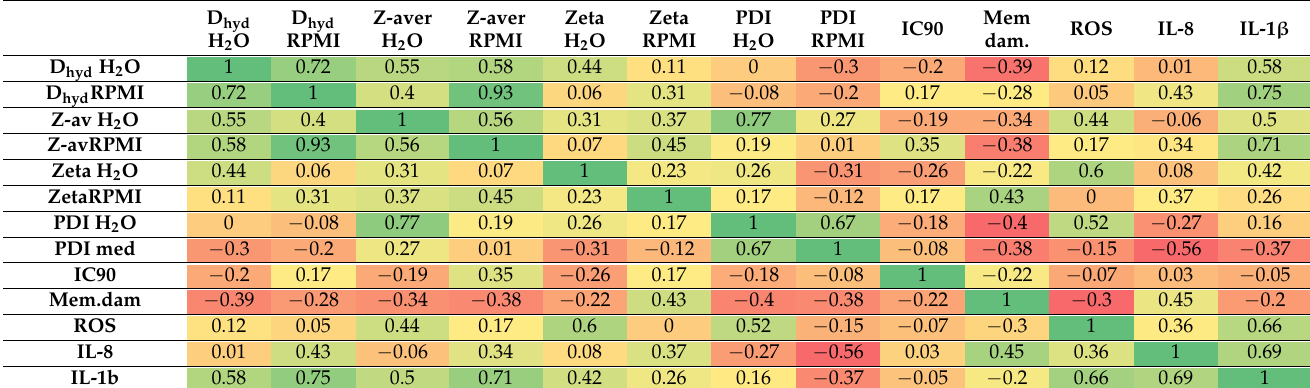
Table 2. Correlations (Spearman coefficient) between NP PCP properties: Size (hydrodynamic diameter D hyd —peak by number distribution) in distilled water (H 2 O) and RPMI media (RPMI) Z- average size (Z-av), zeta potential (Zeta), PDI, and toxicological endpoints: IC90, membrane damage (Memb. dam.), ROS, IL 8, and IL-1 β